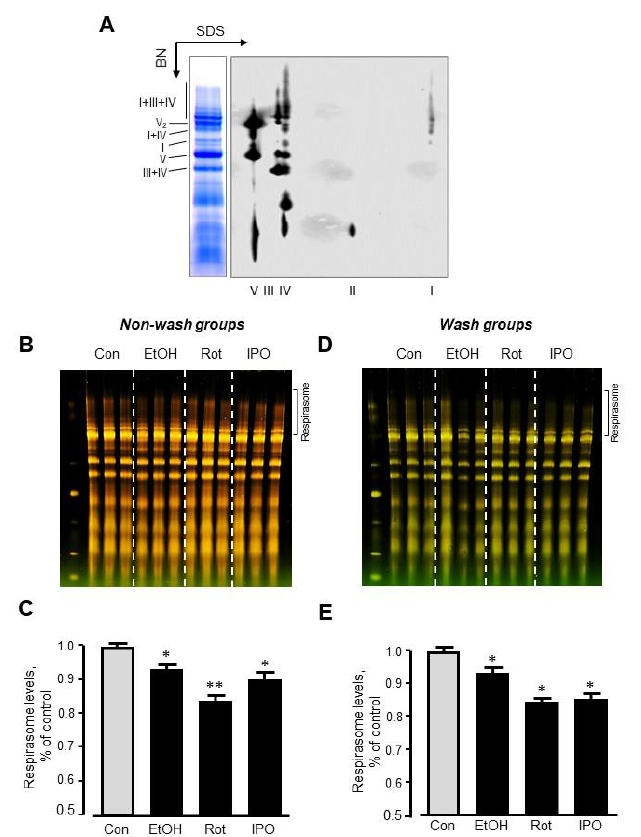
Figure 4. Respirasome levels in mitochondria isolated from non-wash and wash groups by blue-native polyacrylamide gel electrophoresis (BN-PAGE). ( A ) Representative two-dimensional BN-PAGE (2D BN-PAGE) of RCS. Mitochondria were treated with digitonin and subjected to 2D BN-PAGE. ETC complexes were visualized using antibodies against the subunits NDUFB8 (complex I), SDHB (complex II), UQCRC2 (complex III), MTCO1 (complex IV), and ATP5A (complex V). ( B , D ) Representative BN-PAGE images of RCS. ( C , E ) Quantitative data of RCS levels. The levels of respirasome were expressed as a percent change of control (Con). EtOH, ethanol; IPO, isopropanol; Rot, rotenone. * p < 0.05; ** p < 0.01 vs. Con, n = 3 per each group.